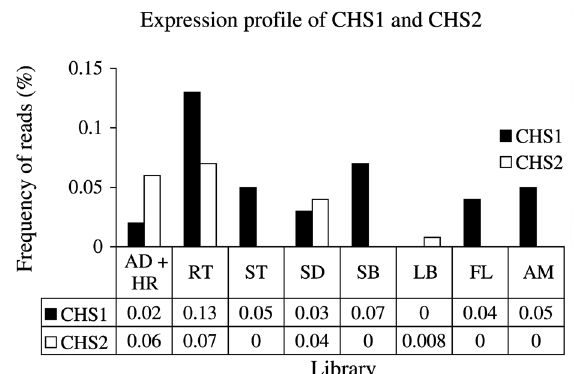
Figure2 -Occurrenceandfrequencyofchalconesynthase1(CHS1)and2 (CHS2) in different sugarcane tissues. Library codes: AD+HR = plantlets infected with Gluconacetobacter diazotroficans and Herbaspirillum rubrisubalbicans (22320 reads), RT = root (23168 reads), ST = stem first internode (14532 reads), SD = seed (15617 reads), SB = s tem bark (11313 reads), LB = lateral bud (12821 reads), FL = flower (47887 reads), AM = apical meristem (20078